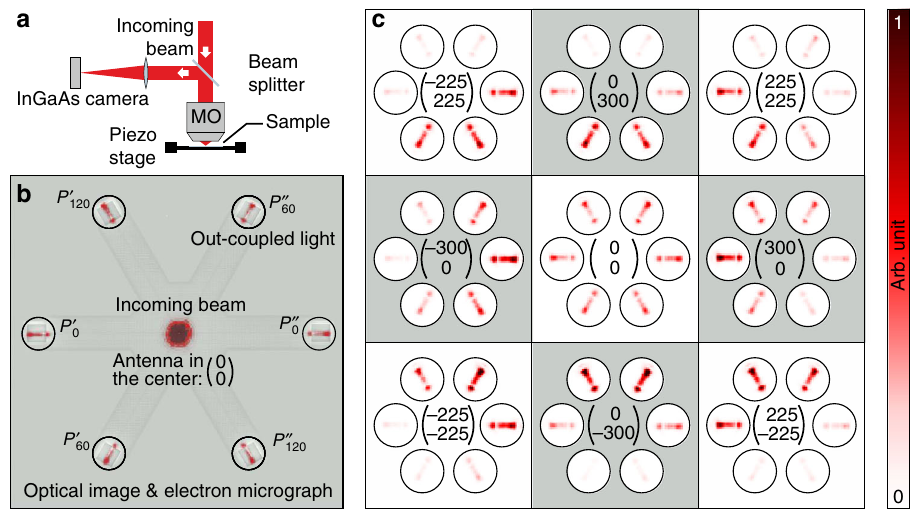
Fig. 3 Optical setup and directional coupling. a The simpli fi ed sketch of the experimental setup shows an incoming radially polarized beam passing through a beam-splitter and being tightly focused by a high numerical-aperture microscope objective (MO) onto the displacement sensor. The sample is imaged by the same MO and an additional lens onto an Indium gallium arsenide (InGaAs) camera. b The exemplary optical image of the sample superimposed on an electron micrograph of the structure shows the incoming beam (see overexposed spot in the center) and the six out-couplers for the antenna being positioned close to the center (optical axis) of the beam. c The images of the out-couplers are plotted for nine different positions relative to the beam, with the x - and y -coordinates being denoted in units of nm in the center of each